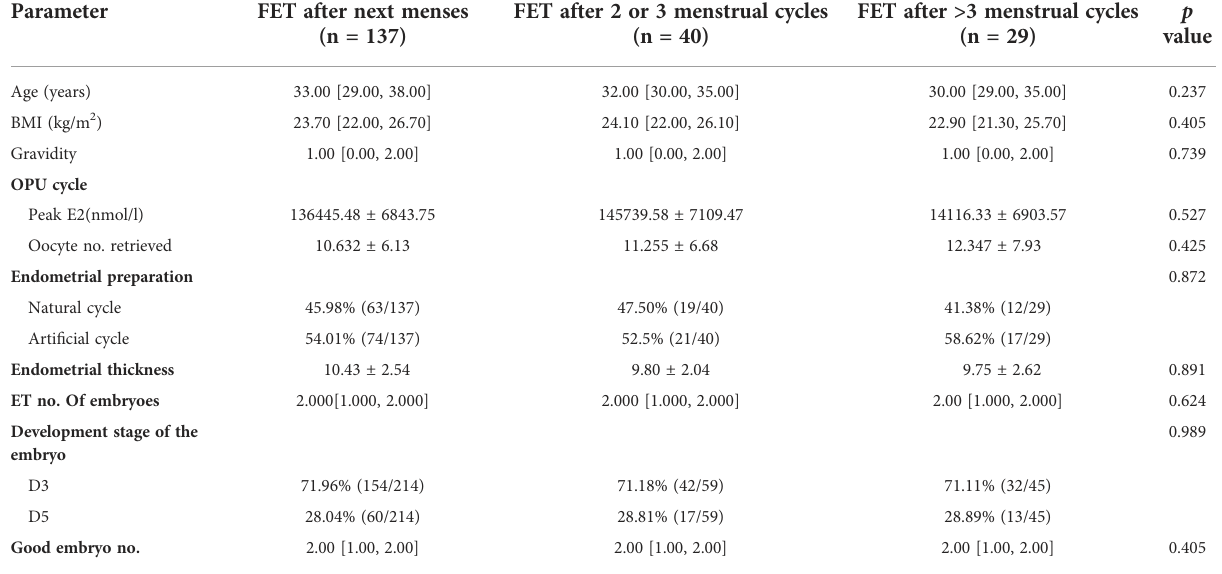
TABLE 2 Subgroup analysis of polypectomy